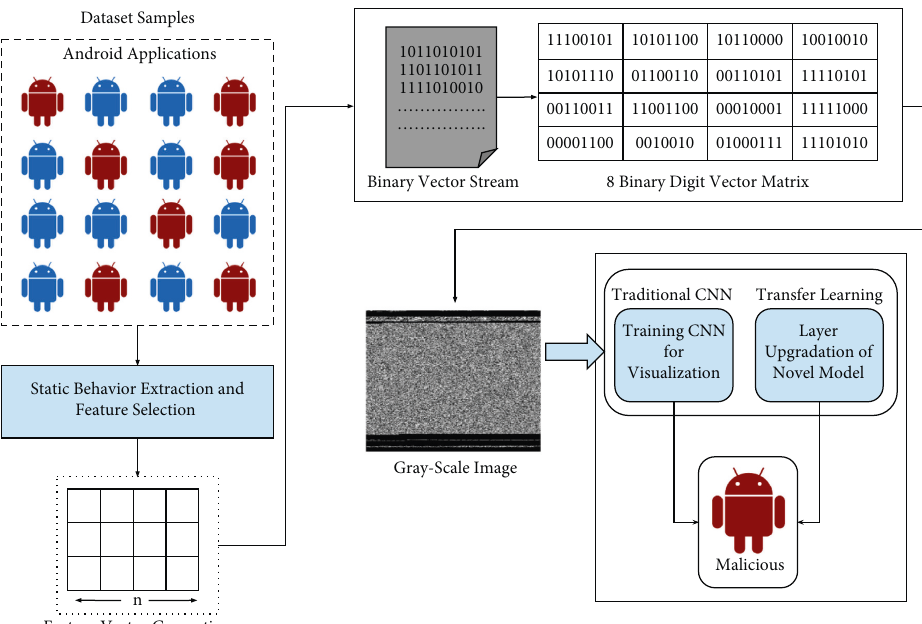
Figure 2: APK to gray-scale image conversion